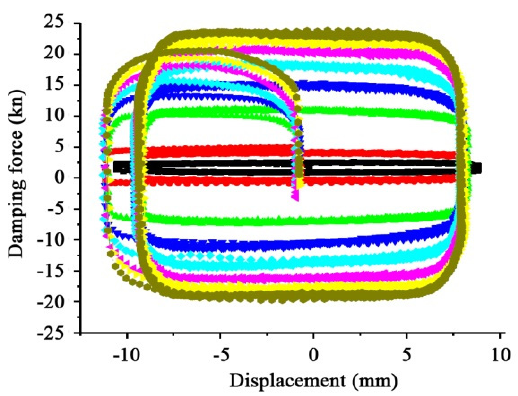
Figure 5. Damper hysteretic curve under peak value of deflection 10 mm and 1-Hz sine wave.